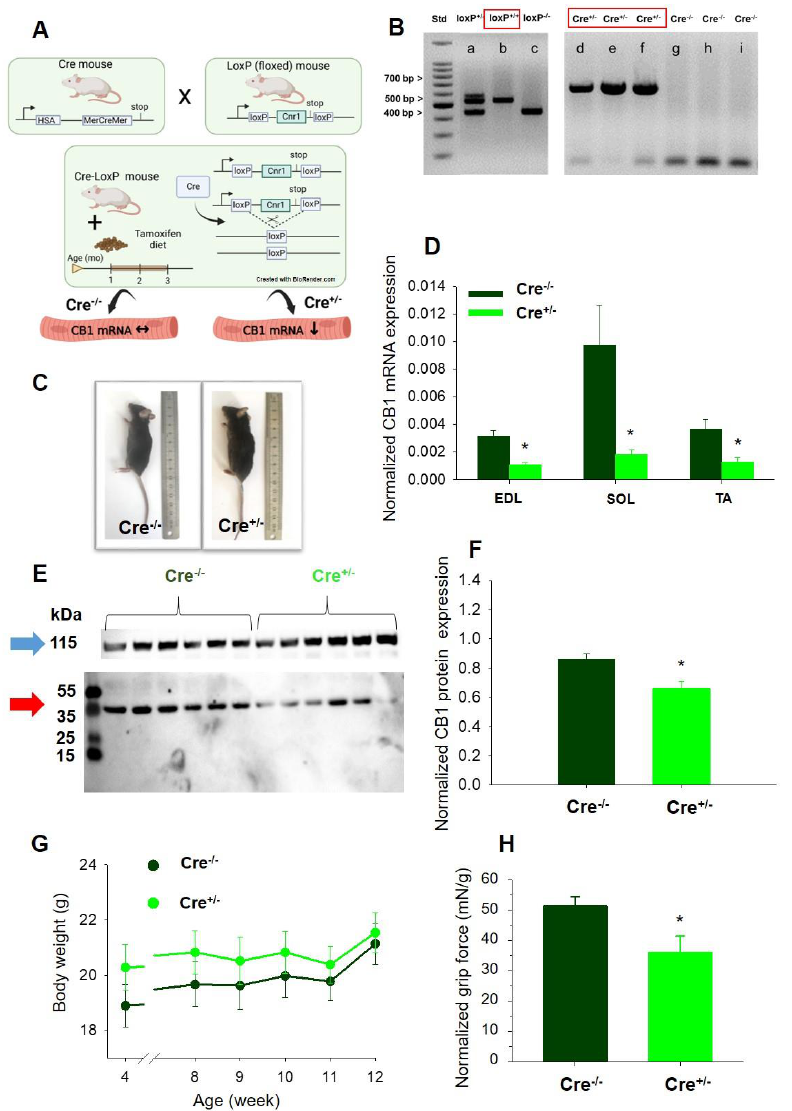
Figure 1. Skeletal muscle − specific knock − down of CB1R. ( A ) Schematic diagram of muscle-specific CB1R-knock-down breeding strategy. ( B ) Validation and identification of the loxP +/ − (a), loxP +/+ (b), loxP − / − (c), Cre +/ − (d, e, f), and Cre − / − (g, h, i) mice via agarose gel electrophoresis. ( C ) Images of Tamoxifen-fed Cre − / − and Cre +/ − mice (all of them loxP +/+ ) at age of 3 months, following 2-month Tamoxifen diet period. The mice did not show any gross visible morphological defects and had normal behavior and movement. ( D ) Pooled data of the normalized CB1 mRNA expression levels in different muscle types (EDL, SOL, and TA) of Cre − / − and Cre +/ − mice. 12 littermates (6 Cre − / − and 6 Cre +/ − mice) were examined from 3 litters (breeding groups). PPIA (Peptidylprolyl Isomerase A) was used as internal control. ( E ) Representative Western Blot performed on TA muscles illustrating CB1 protein expression (red arrow, ~45 kDa) and α -actinin (blue arrow, ~115 kDa) that was used as normalizing gene. ( F ) Bar graph depicting average normalized CB1 protein level examined for both samples in 4 independent experiments. ( G ) Change in body weight during the 2-month Tamoxifen diet monitored for mixed gender Cre − / − ( N = 9) and Cre +/ − ( N = 13 mice). ( H ) Grip force normalized to body weight in Cre − / − and Cre +/ − mice ( N = 4 for each group). * p <